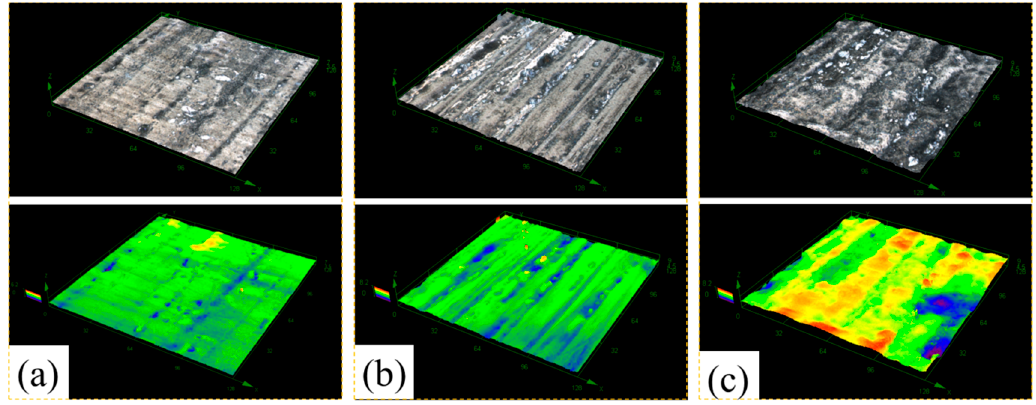
Figure 6. LSCM morphologies of 2A02 Al alloy substrate on removal of corrosion products after corrosion 72 h ( a ) at 30 ◦ C; ( b ) at 60 ◦ C; and ( c ) at 80 ◦ C.